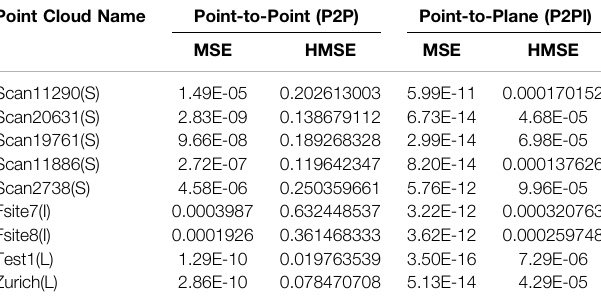
TABLE 3 | The objective distance measurement is based on Point-to-Point and Point-to-Plane metrics. Point Cloud Name